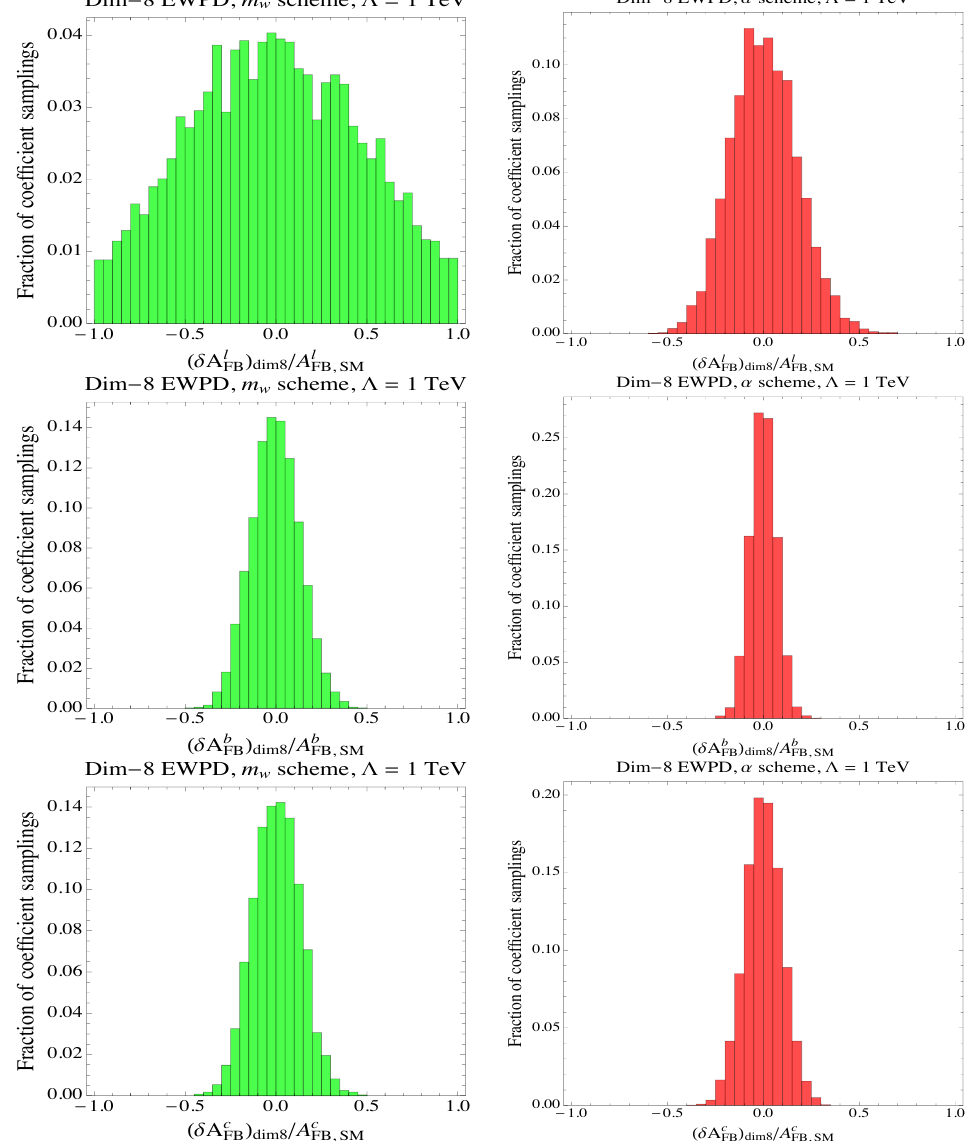
Figure 2 . Contributions to the A ‘ value. Here Λ = 1 TeV. The histograms are formed by selecting random values for the coefficients 5000 times following the scheme described in the